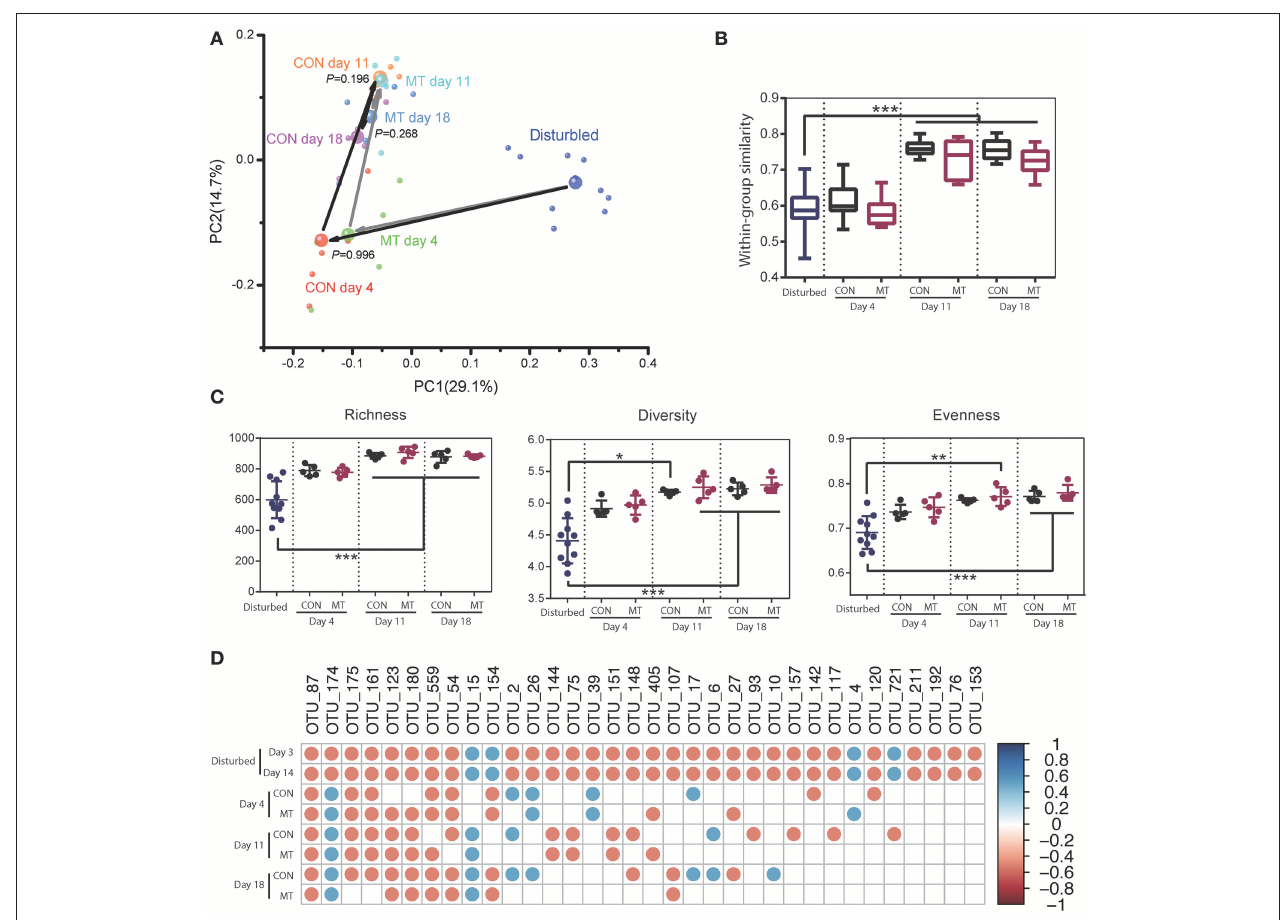
FIGURE 6 | Restoration of hindgut microbiota with or without microbiota transplantation. (A) Hindgut microbiota change for CON and MT groups in the first two dimensions of PCoA. Each small bubble represents one individual cow microbiota and big one represents the representative microbiota in each group. Arrows in dark represent the microbiota change for CON group and those in gray represent the microbiota change for MT group. Microbiota from CON and MT groups at same time point were compared with ANOSIM analysis. (B) Within-group similarities of hindgut microbiota in CON and MT groups changed over time. (C) Richness, diversity and evenness of hindgut microbiota in CON and MT groups change over time. (D) The restoration of antibiotic disturbed high-confidence OTUs in hindgut of CON and MT groups over time. All OTUs compared with those in pre-treated cows (Start group as shown in Figure 4 ); only significantly changed OTUs at both 3 and 14 days post antibiotics administration were shown; blue dots represent significant increase and red dots represent significant decrease. Data are expressed as mean ± s.d. * P < 0.1, ** P < 0.05, *** P <